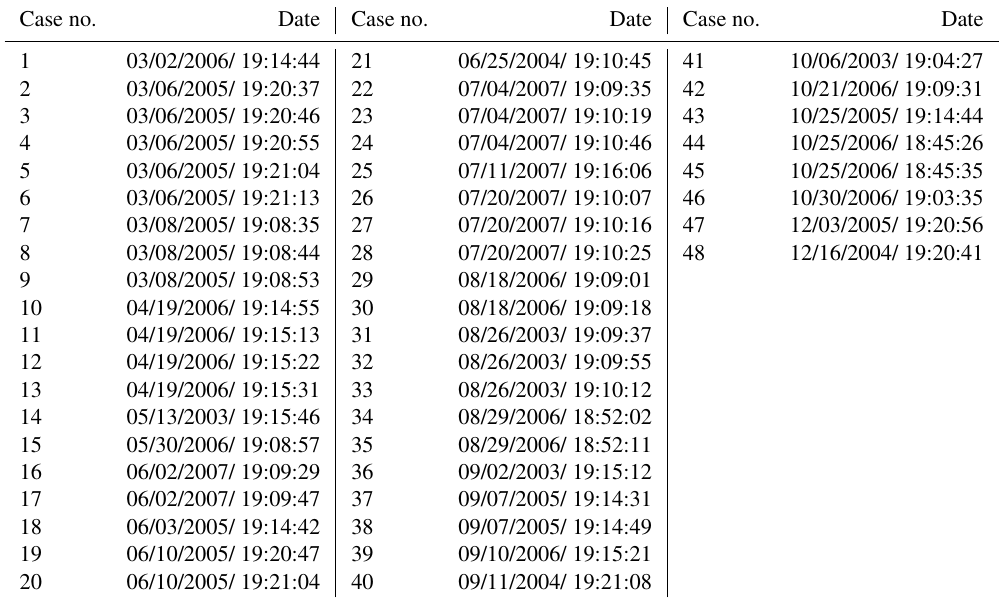
Table 2. Case number (C1–C48) and sample date of each MBL scene in this study. The date format is MM/DD/YYYY hour:minute:second. Case no. Date Case no. Date Case no.